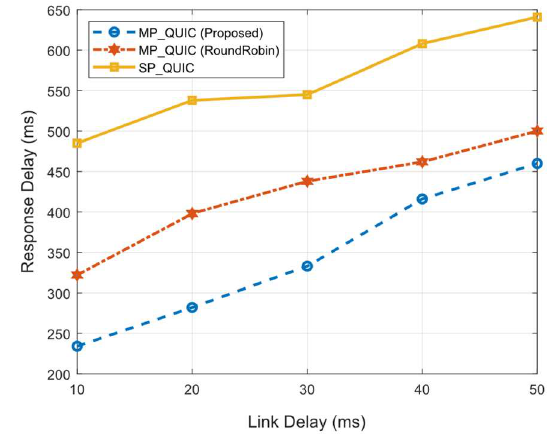
Figure 3. Comparison of response delays for different link delays.